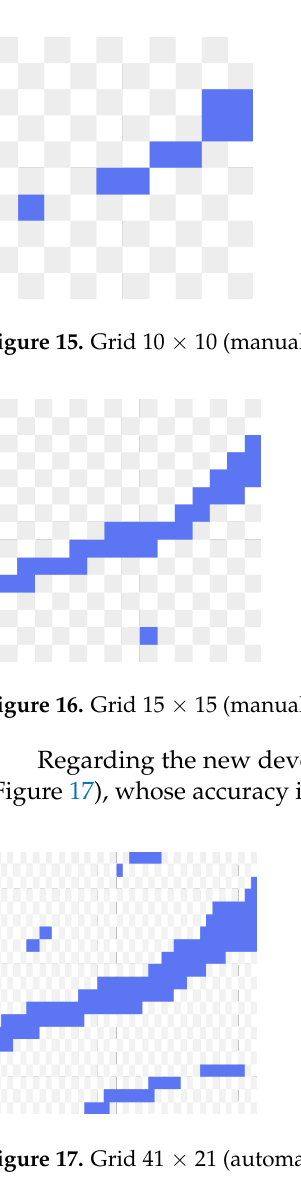
Figure 17. Grid 41 × 21 (automatic). Table 5. Ultrasonic tomography — accuracy results.